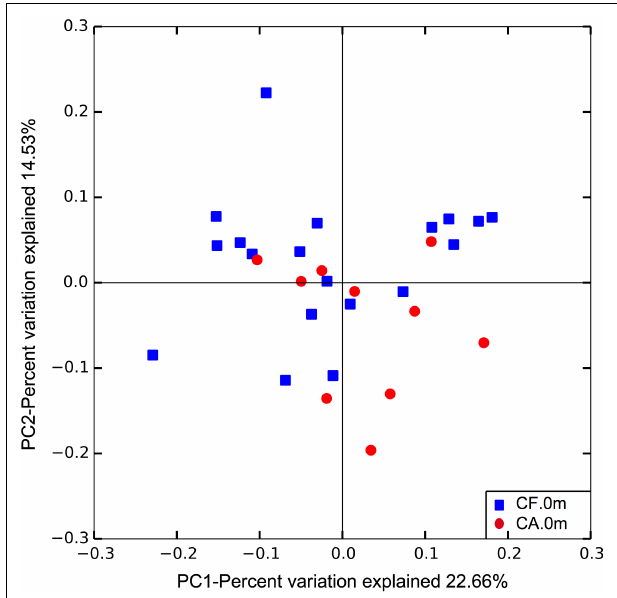
FIGURE 5 | Principle coordinates analysis (PCoA) plot of supragingival microbiome community structure at baseline. The analysis was done based on unweighted UniFrac distance. Dissimilarity analysis done by Adonis exhibits p =